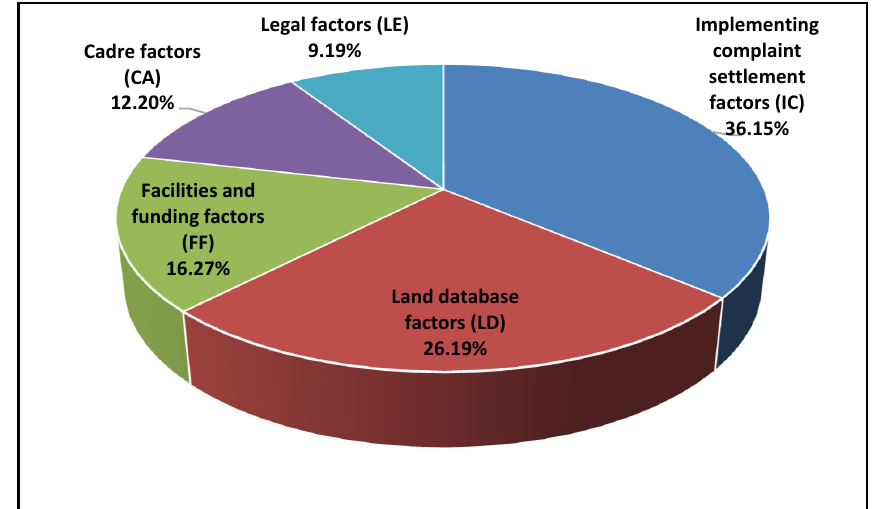
Fig. 5. Influence ratio of factor groups to the land complaint settlement in Bac Ninh